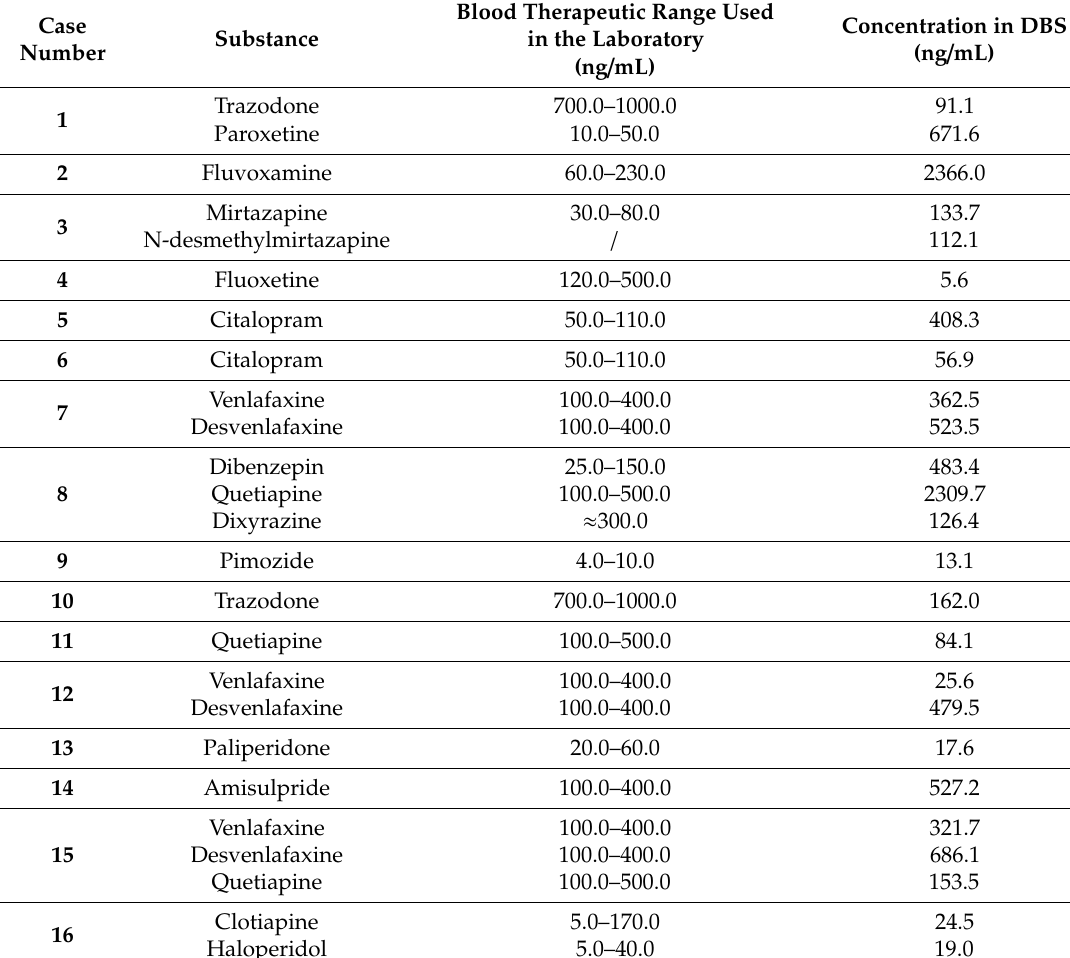
Table 4. Concentrations of the 16 positive dried blood spot (DBS) samples at